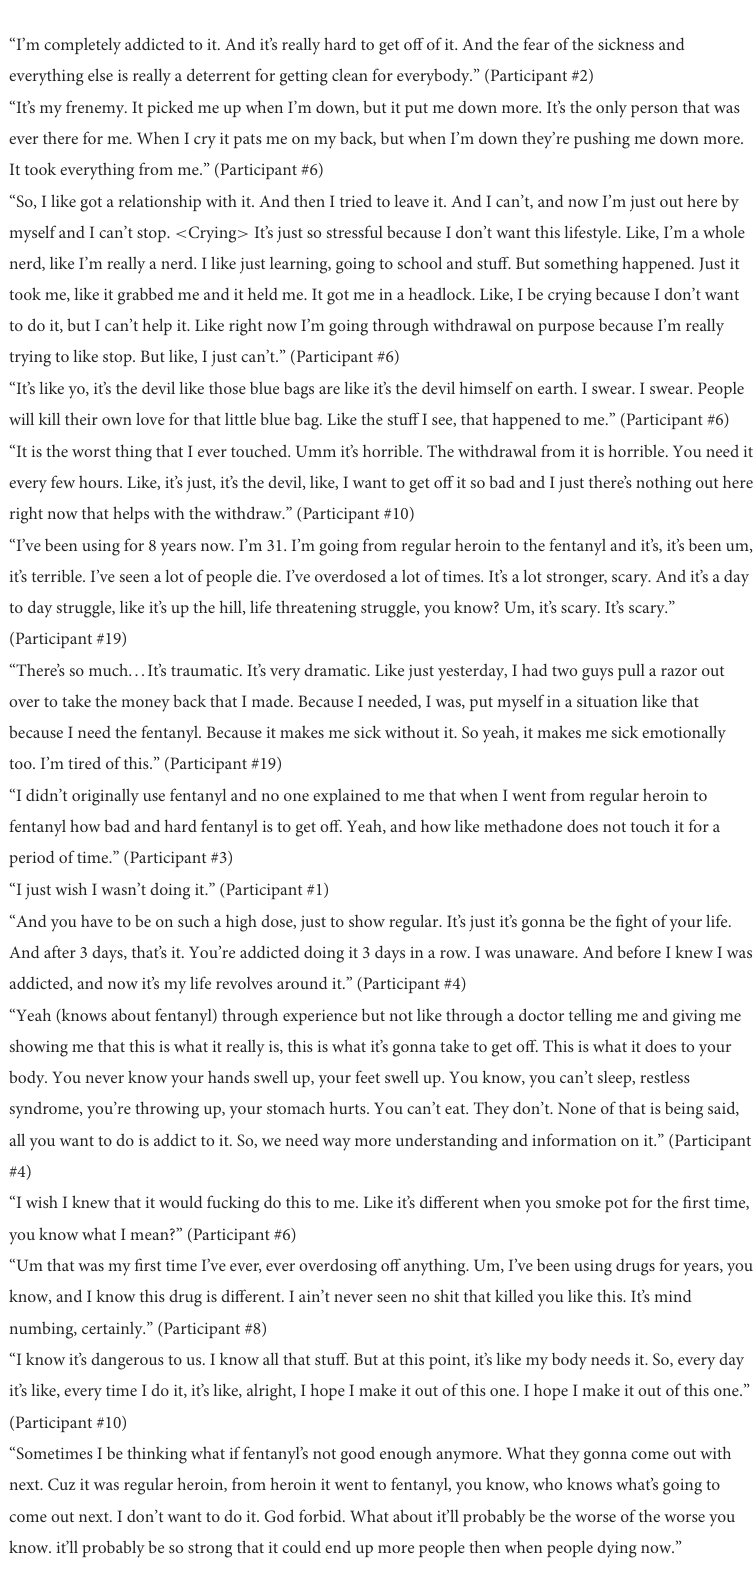
TABLE 2 Selected quotes by research